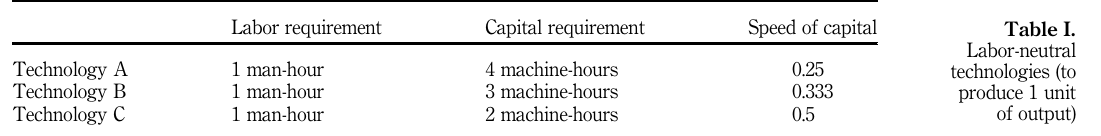
Table I. Labor-neutral technologies (to produce 1 unit of